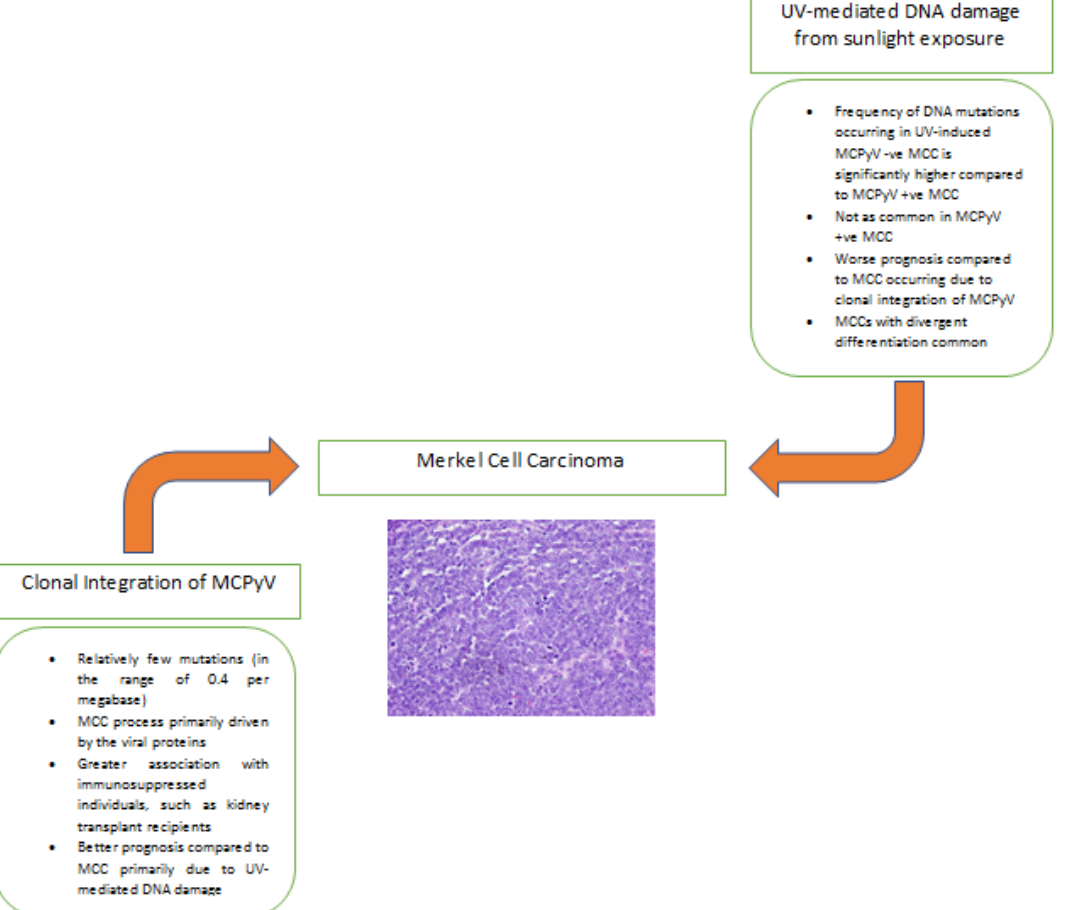
Figure 1. Clonal integration of MCPyV and UV ‐ mediated DNA damage from sunlight exposure carcinogenesis models of MCC. DNA: Deoxyribonucleic acid; MCC: Merkel Cell Carcinoma; MCPyV: Merkel Cell Polyomavirus; UV: Ultraviolet.